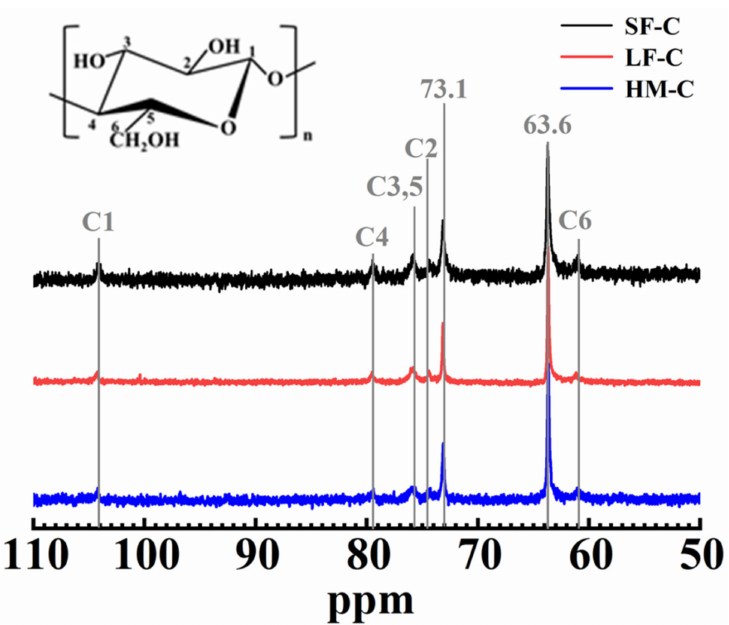
Figure 3. 13 C-NMR spectra of three kinds of 4.0-wt% cellulose in 1.0-wt% glycerin / 9.0-wt% NaOH / D 2 O aqueous